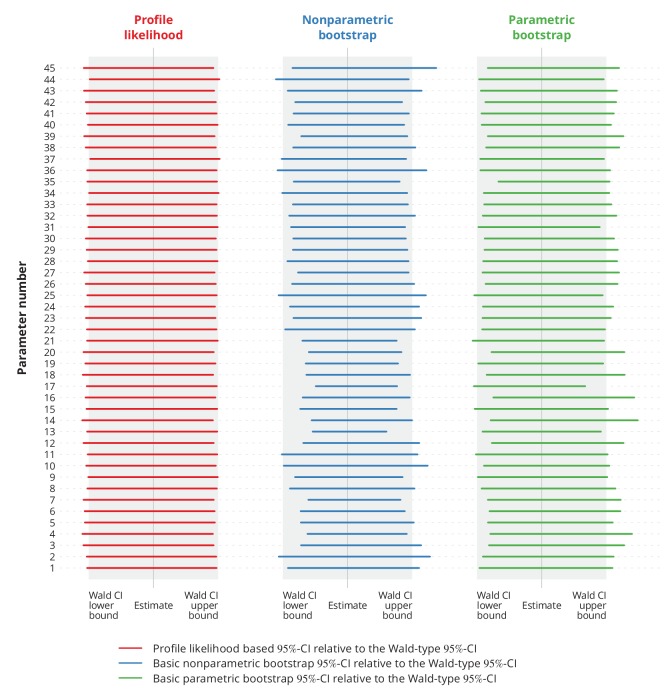
Comparison of different types of 95%-confidence intervals (CI) with the normal approximation based Wald-type 95%-CIs.Each column corresponds to a different type of CIs, namely the profile likelihood based CIs, the basic nonparametric bootstrap CIs and the basic parametric bootstrap CIs. Each row represents a single parameter (the overview of the parameters is provided in Appendix 1—table 1). The colorful lines show the specific CIs compared to the corresponding Wald-type CIs, namely their relative widths and positions. The gray-shaded areas represent the Wald-type 95%-CIs.